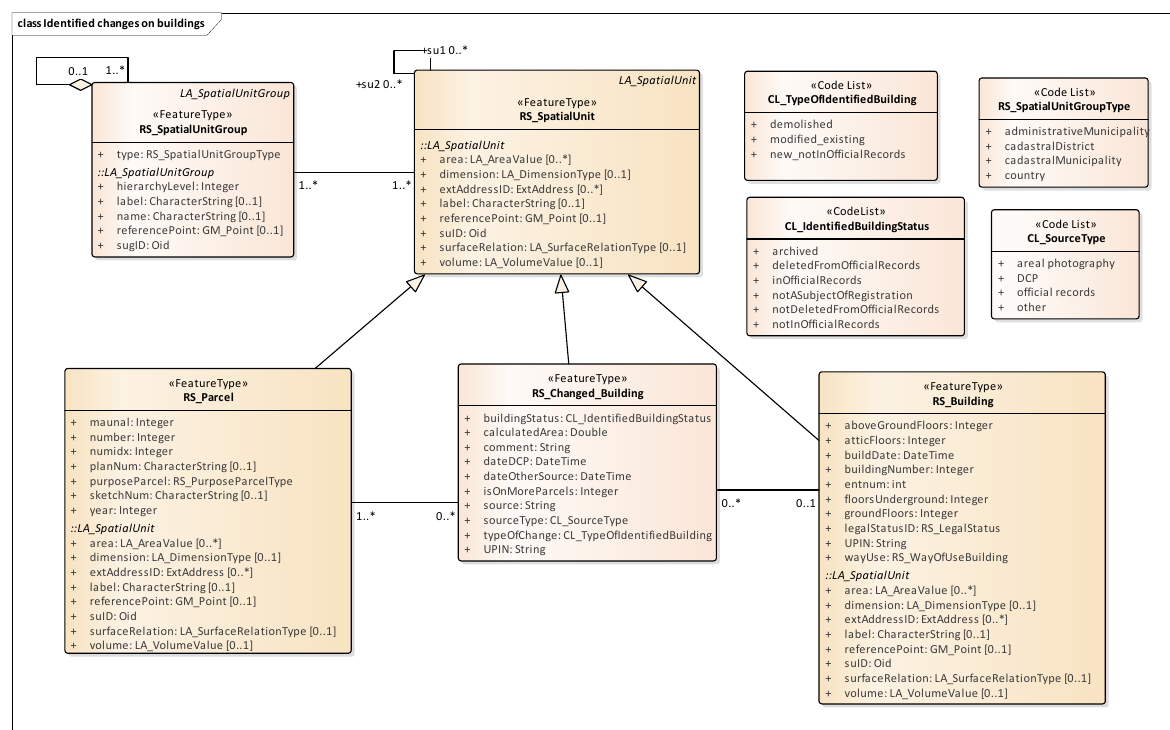
Figure 8. Proposed conceptual model for the register on determined changes on buildings.